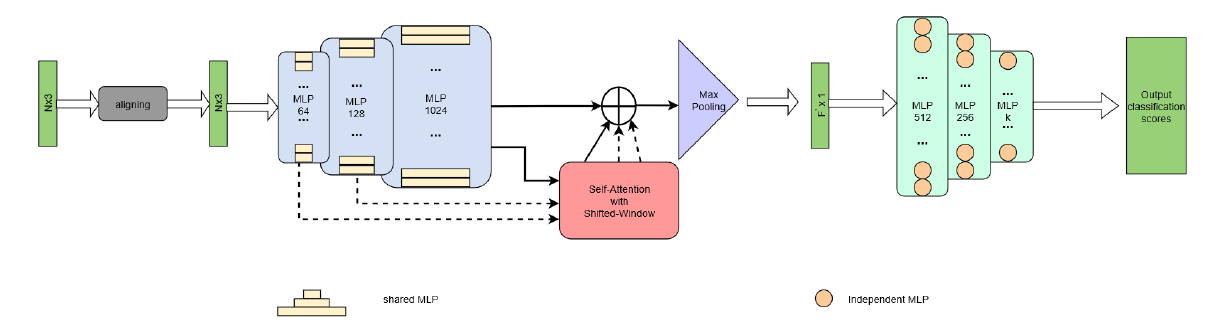
Figure 2. Illustration of the overall architecture of PointSwin and PointSwin-E. In the Self-Attention with Shifted-Window part, the part with a solid line in and out is combined with other parts as PointSwin. In the Self-Attention with Shifted-Window part, the part that enters and exits as a dotted line is combined with other parts as